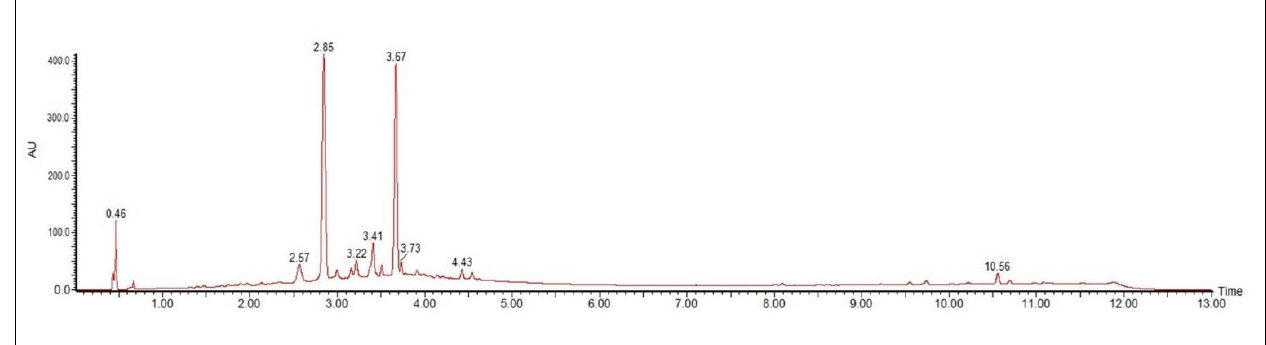
Figure 1. RP-UPLC-DAD profile of ethanolic extract of A. chica leaves. Conditions: CHS130 100 RP-18 column (1.7 μm, 50 × 3 mm i.d.). Elution was carried out with a linear gradient of water with 0.1% formic acid and acetonitrile with 0.1% formic acid (from 5% to 95% of acetonitrile with 0.1% formic acid in 11 min), and the UPLC fingerprints were registered on an ACQUITY (Waters) apparatus with a UV-DAD detector (Waters 2996).